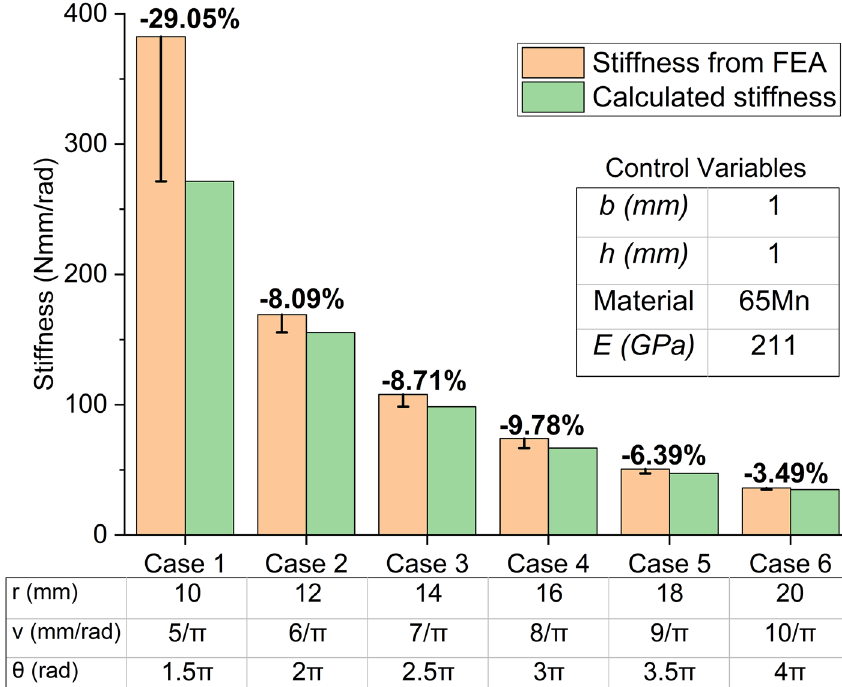
Figure 2. Comparison and parameters of six spring arm cases.